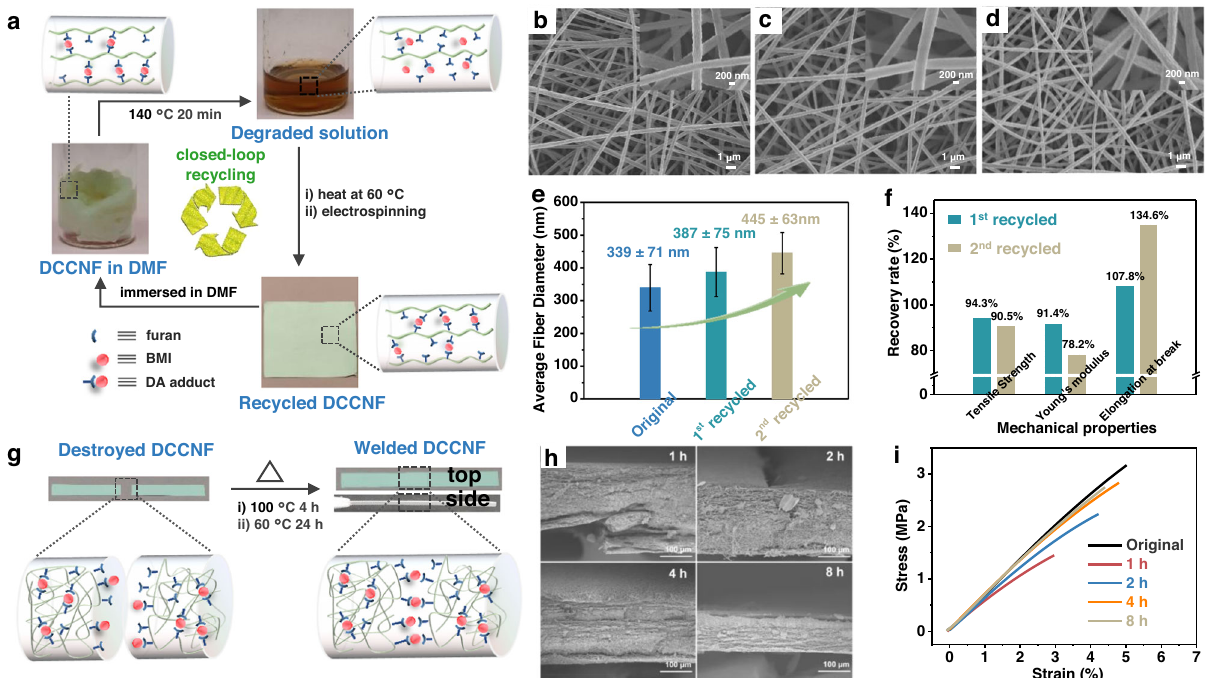
Fig. 6 | Closed-loop recycling and welding of DCCNFs. a Schematic representa- tion of the one-pot closed-loop recycling process of DCCNF-60C; b – d FESEM imagesof b )original, c )1 st recycled,and d )2 nd recycledDCCNF-60C; e Average fi ber diameters of original and recycled DCCNF-60C; f Recovery rate of mechanical